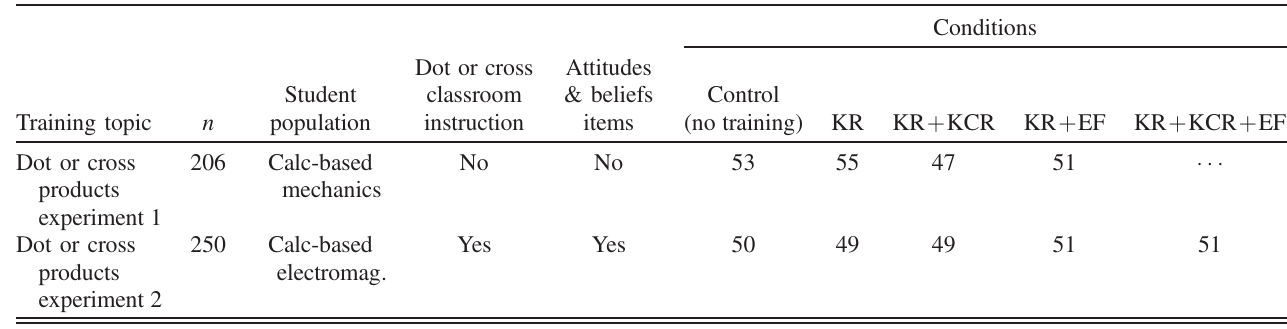
TABLE II. Experimental design. Note that numbers are counts of